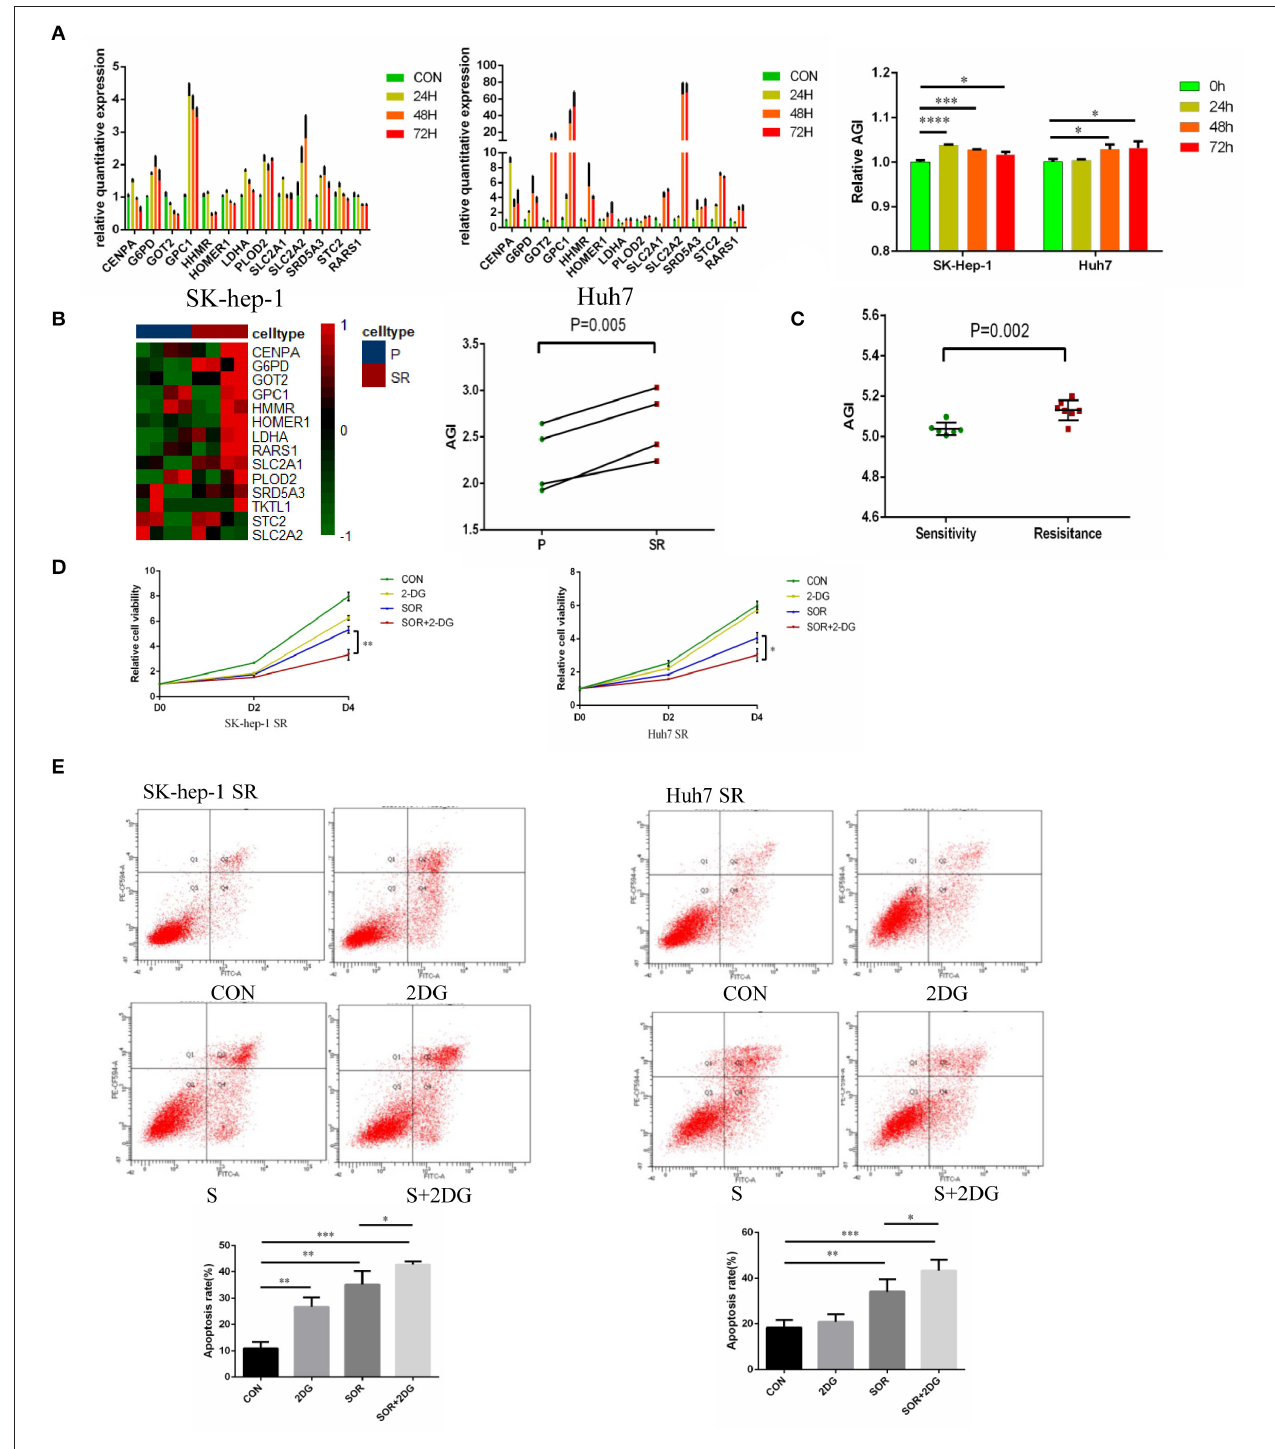
FIGURE 7 | Aerobic glycolysis index (AGI) is increased in Sorafenib-resistant hepatocellular carcinoma (HCC) cells. (A) Relative expression of AGI-related genes in HCC cell lines (left, SK-hep-1; right, Huh7) incubated with Sorafenib (5 µ M) for 24, 36, and 72h. (B) Distribution of the 14 AGI-related gene expression profiles in parental and Sorafenib-resistant HCC cell lines (SK-hep-1, Huh7). (C) AGI of Sorafenib-sensitive and Sorafenib-resistant xenografts from the GSE73571 dataset. (D) Combination of 2-DG and Sorafenib resulted in significantly decreased cell viability. (E) Combination of 2-DG and Sorafenib enhanced the apoptosis of Sorafenib-resistant cell lines (SK-hep-1SR and Huh7SR). * P < 0.05, ** P < 0.01, *** P < 0.001.